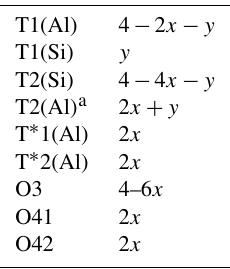
a corresponds to the net excess of Al on T2(Si). Note: atomic sites not listed here are fully